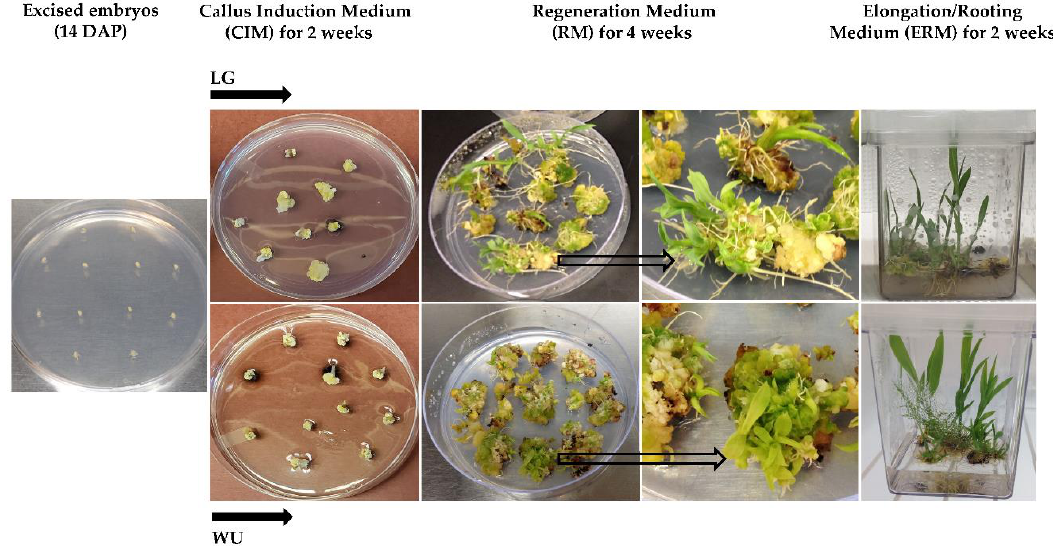
Figure 1. The in vitro tissue culture steps used for the Liu and Godwin (LG) and Wu et al. (WU) protocols, leading to plantlet regeneration, with Tx430 shown as the representative genotype. Arrows denote individual explants enlarged in the right RM panel photo.